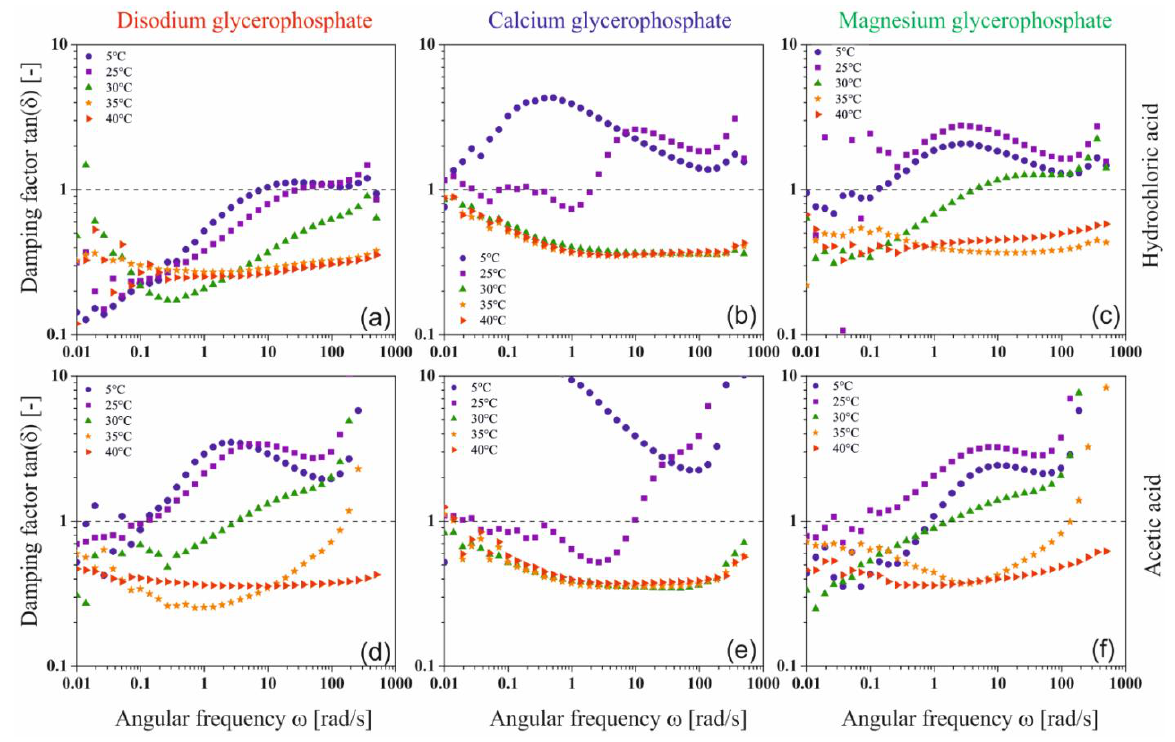
Figure 9. Changes in the value of the damping factor for chitosan chloride ( a – c ) and acetate ( d – f ) systems containing sodium glycerophosphate, calcium glycerophosphate, and magnesium glycerophosphate.